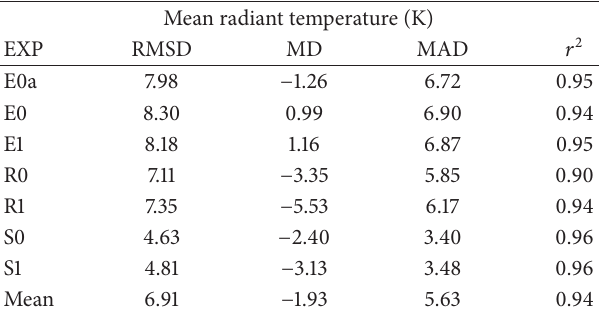
Table 5: Overview of the performance of the experiments (EXP) in simulating mean radiant temperature on 7, 23, 2013, regarding root-mean-square deviation (RMSD), mean deviation (MD), mean absolute deviation (MAD), and coefficient of determination ( 𝑟 2